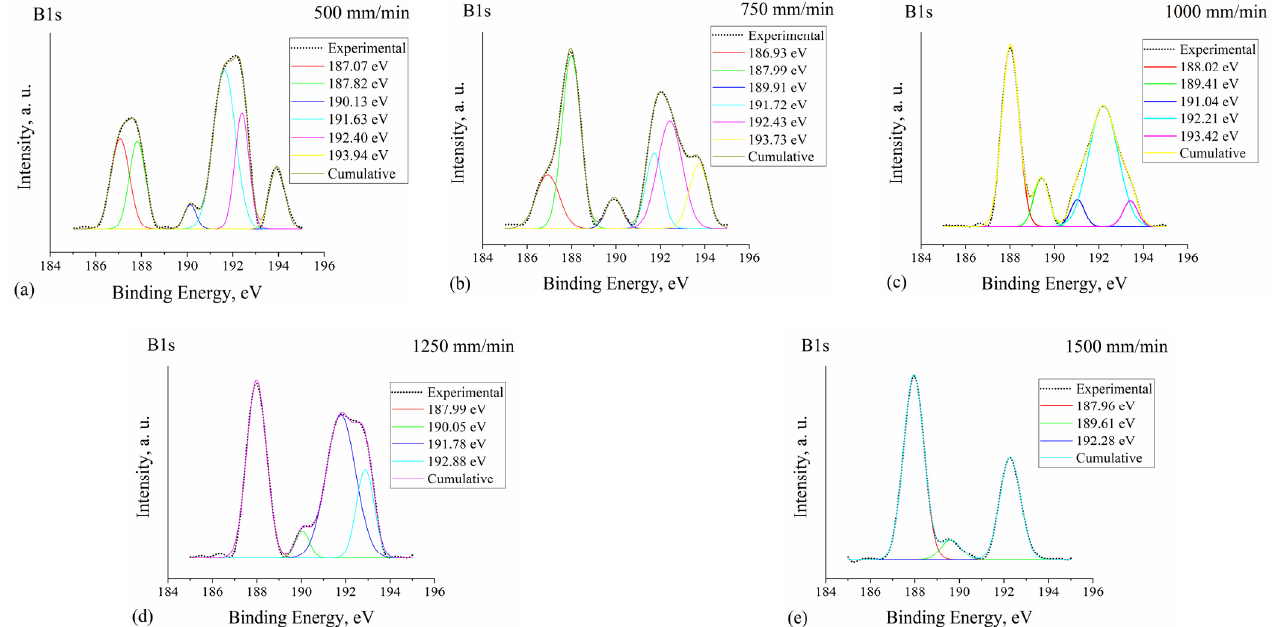
Figure 5. XPS spectra for B1s peaks with fitting curves for the specimens laser boronized at 500 mm/min ( a ), 750 mm/min ( b ), 1000 mm/min ( c ), 1250 mm/min ( d ) and 1500 mm/min ( e ) laser operating speeds.